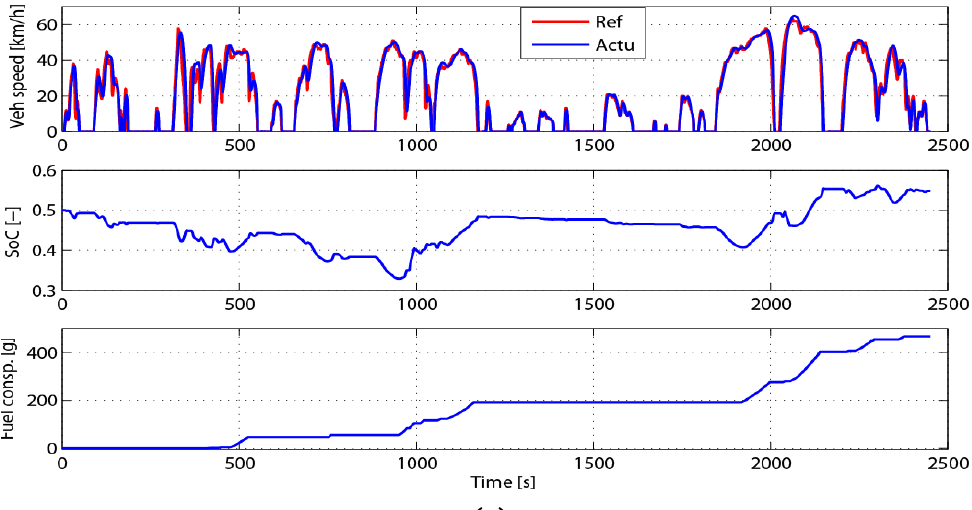
Figure 15. Result with the full-policy for the first Wednesday speed profile. ( a ) Vehicle speed, SoC and fuel-electricity consumption; ( b ) Batter power, demand power and engine, generator and motor power outputs; ( c ) Engine, Generator, motor speeds and their torques; ( d ) Engine operating point